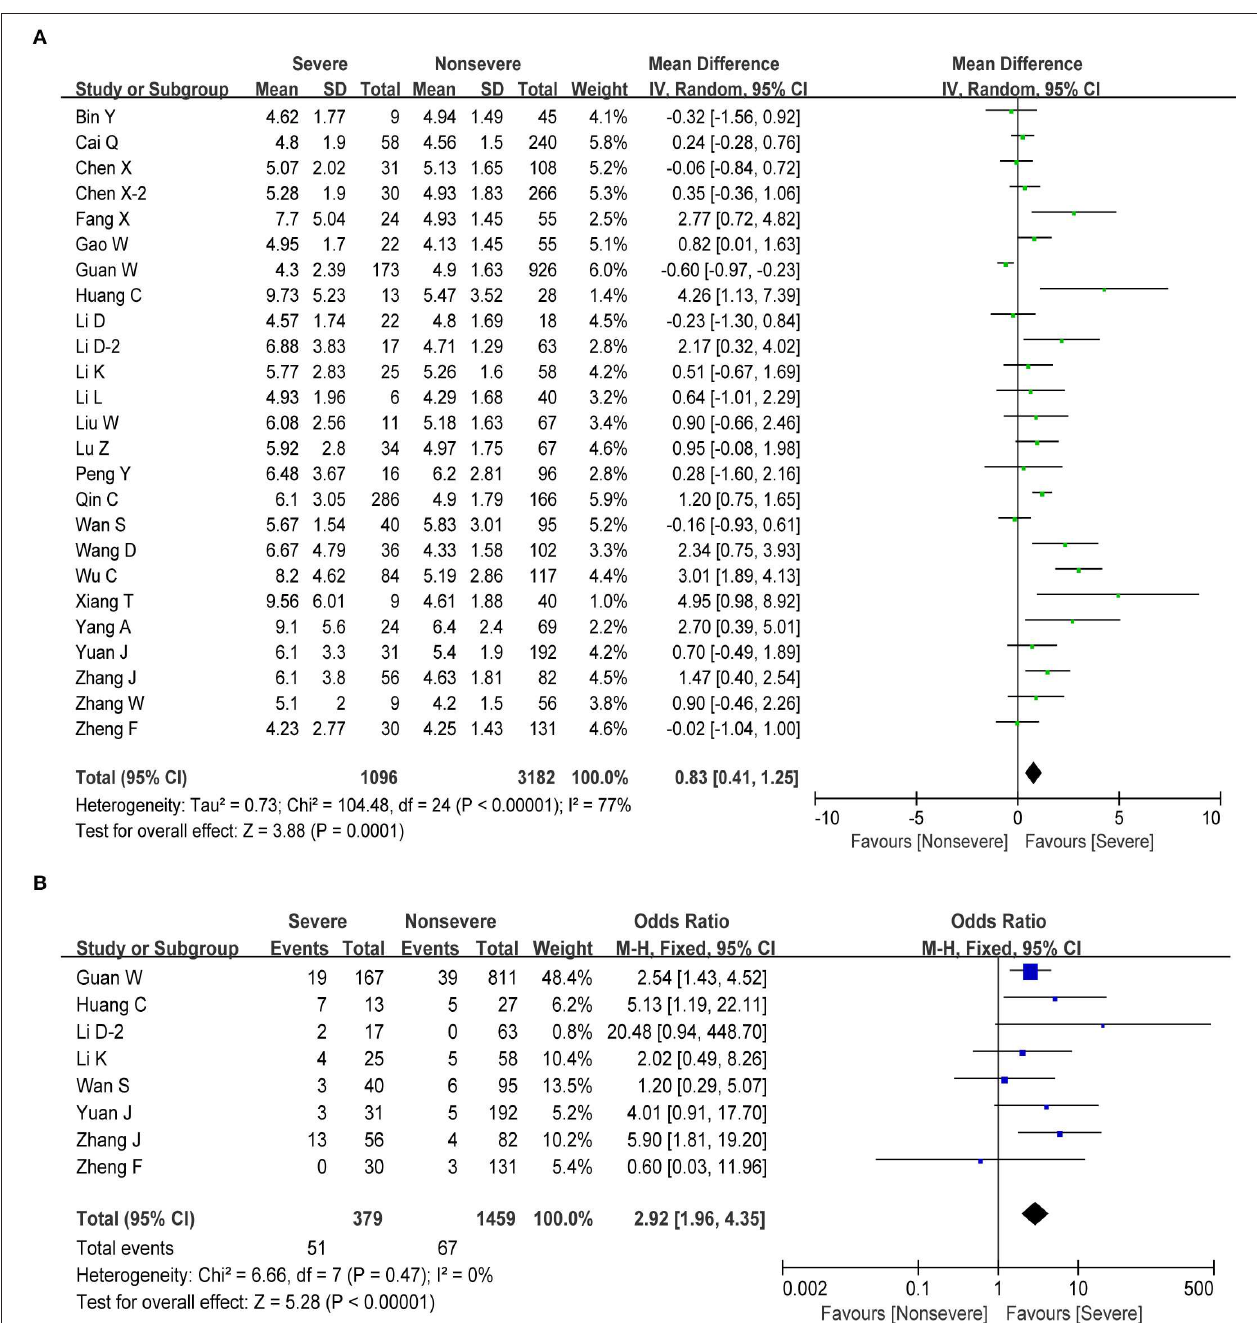
FIGURE 2 | Correlation between WBC and disease severity of COVID-19. (A) Forest plot of mean difference in WBC count. (B) Forest plot of OR for the association of elevated WBC with disease severity.